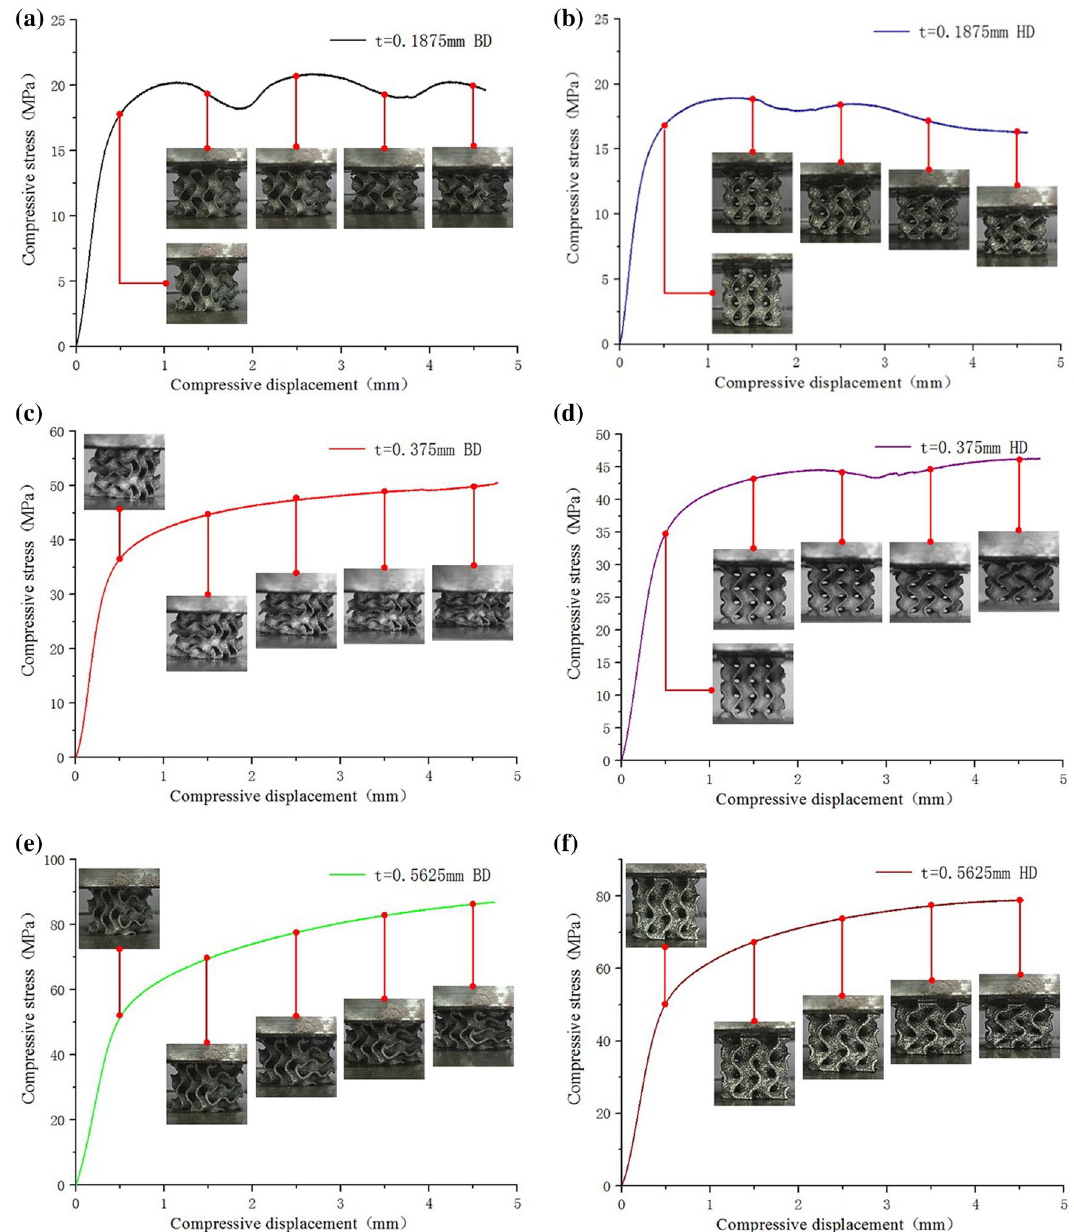
Figure 20. Compression deformation of Gyroid surfaces with different wall thickness: ( a ) t = 0.1875 mm BD; ( b ) t = 0.1875 mm HD; ( c ) t = 0.375 mm BD; ( d ) t = 0.375 mm HD; ( e ) t = 0.5625 mm BD; ( f ) t = 0.5625 mm HD; ( g ) t = 0.75 mm BD; ( h ) t = 0.75 mm HD; (i) t = 0.9375 mm BD; ( j ) t = 0.9375 mm HD; ( k ) t = 1.125 mm BD; ( l ) t = 1.125 mm